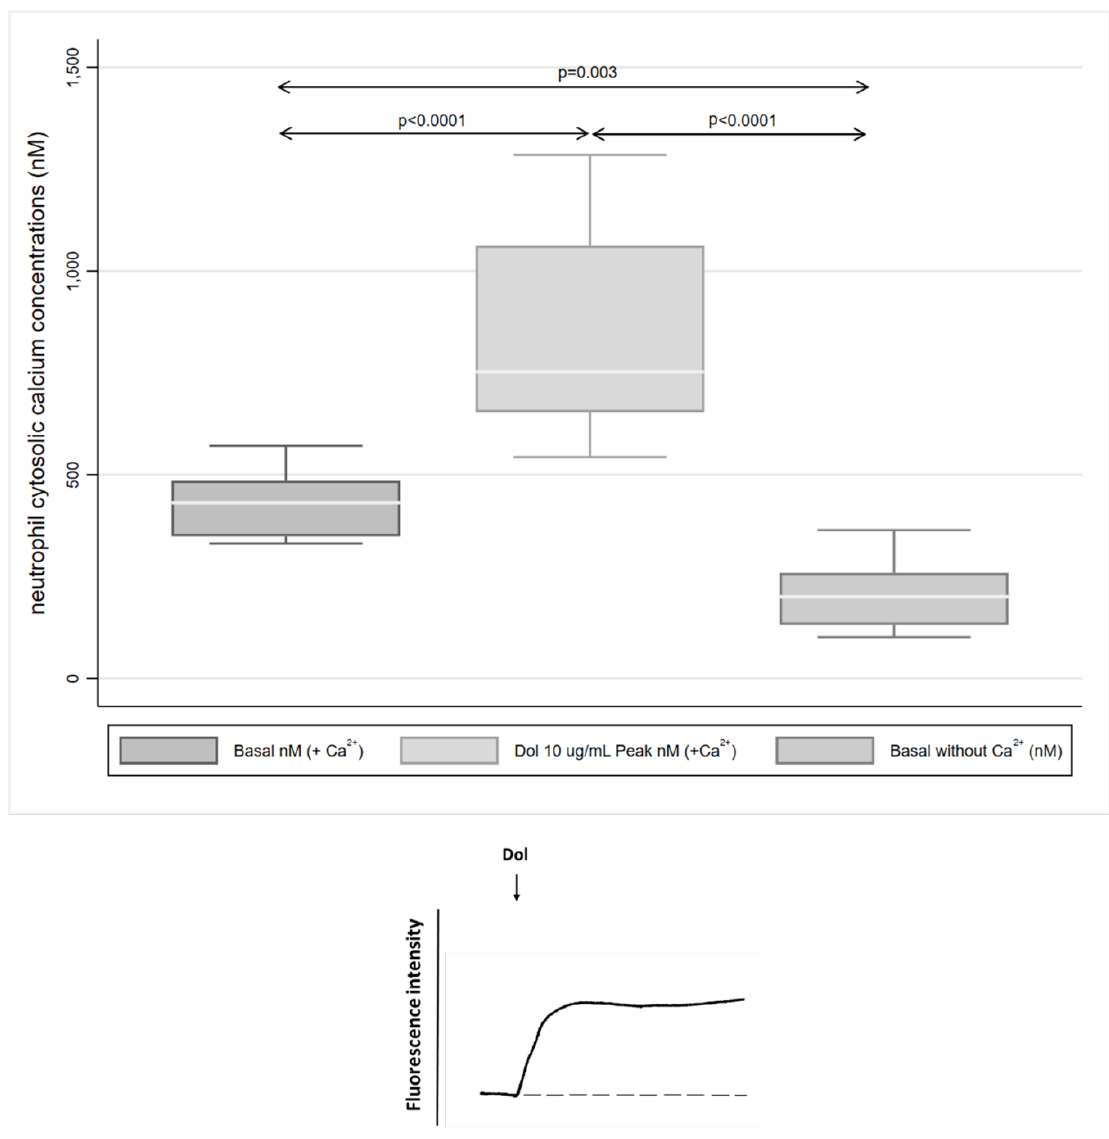
Figure 3. Effects of dolutegravir on neutrophil cytosolic Ca 2+ concentrations. Dolutegravir (Dol,